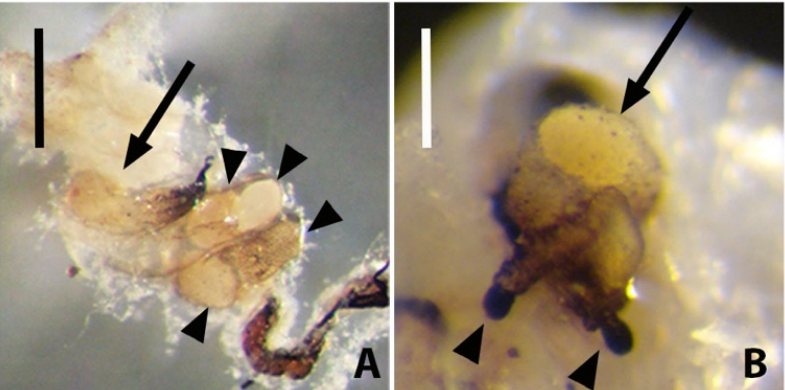
Figure 8. Experimental zooids and colonies. ( A ) A brooding chamber made of a smooth and spiraled creeping tube. Female zooid (arrow) and larvae (arrowheads). ( B ) Female zooid with ovary (arrow) and reduced tentacles (arrowheads). Scale bars 350 µm for ( A ), 150 µm for ( B ).